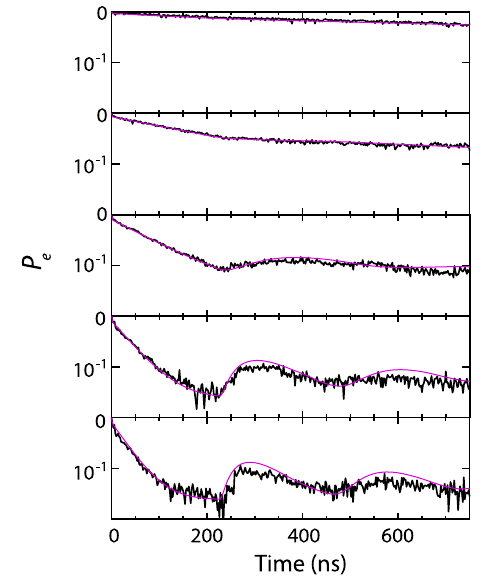
ffiffiffiffiffiffiffiffiffiffiffiffiffiffiffi p Γ π 1 D v=